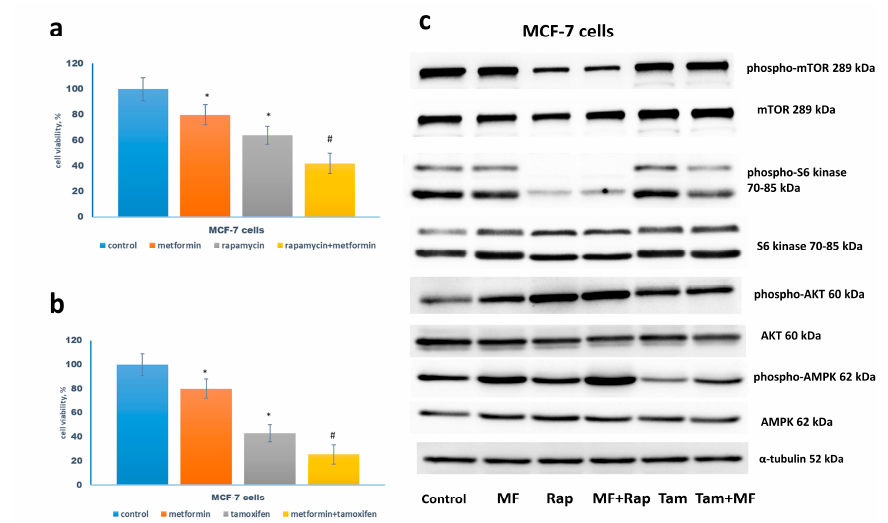
Figure 1. Drug sensitivity of MCF-7 cells. ( a , b ) Cell growth. The cells were treated without or with 1 µ M rapamycin and / or 2 mM metformin ( a ), 5 µ M tamoxifen and / or 2 mM metformin ( b ) for 3